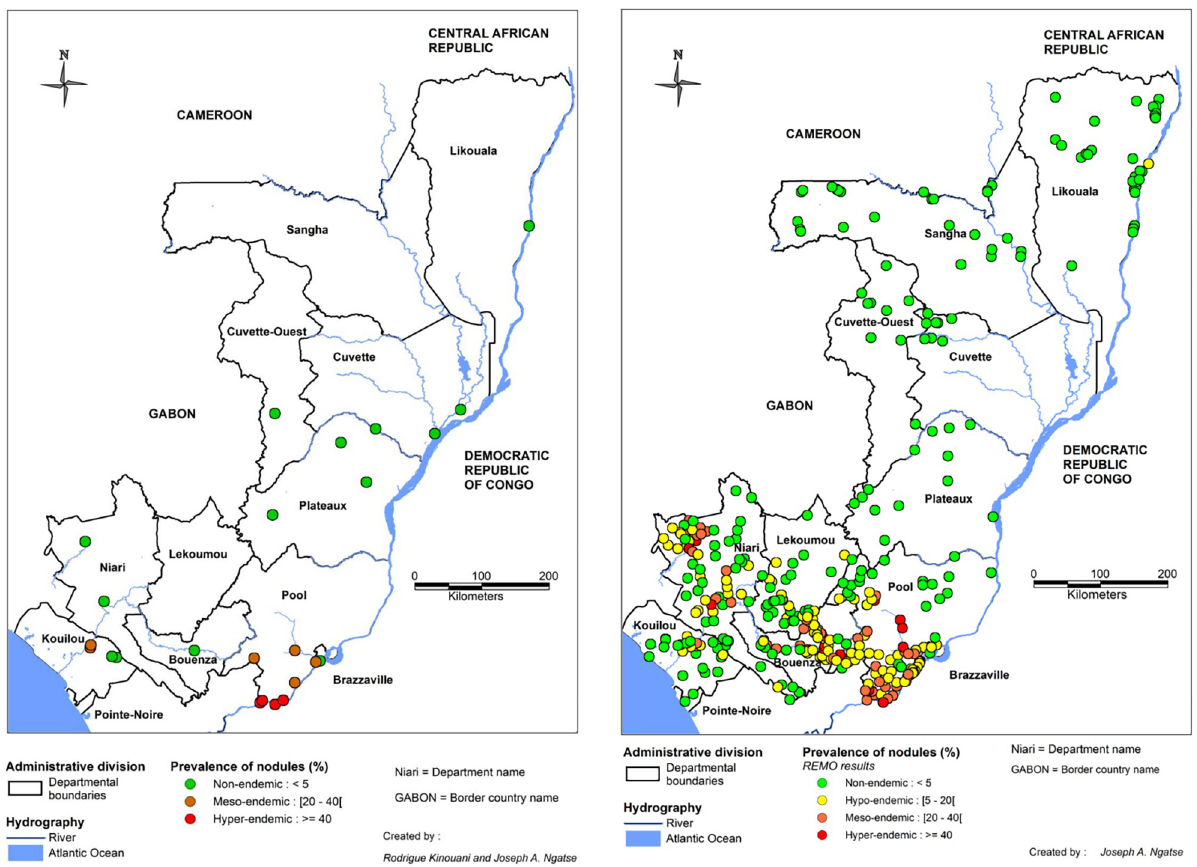
Fig 4. Distribution of the prevalence of onchocercal nodules in the Republic of the Congo. The left panel shows the surveys conducted from 1960 to before REMO (2001); the right panel shows the APOC’s REMO surveys. The map was created with MapInfo 8.5 (Geographic Information System, http://www.precisely.com). The base layer used of the map was created by the « Laboratoire Population Environnement De´veloppement » (LPD, UMR 151 AMU-IRD) (https://www.lped.fr/-observatoires-societe-environnement-.html) under the supervision of the Ministry of Health and Welfare of the Republic of